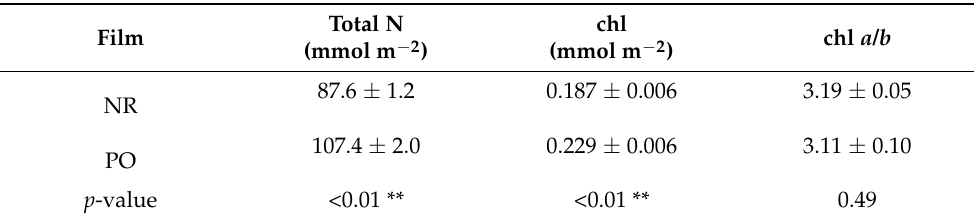
Table 4. Effects of high tunnel-covering film on total nitrogen (N) and chlorophyll (chl) content per leaf area and on the chl a/b